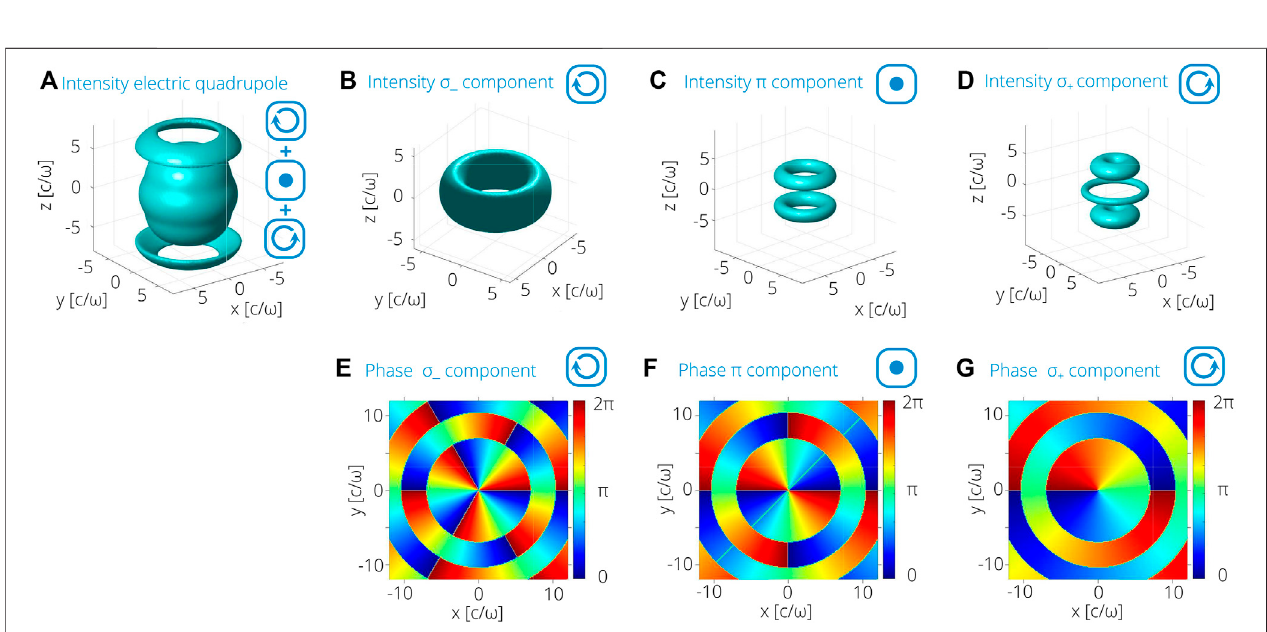
FIGURE 3 | Isosurfaces of an electric quadrupole Y ( E ) 22 spherical wave at 40% of the intensity divided into: (A) total intensity; (B) σ − polarization component; (C) π polarization component; and (D) σ + components of the polarization. In (E – G) the phase distributions at the z = 0 plane are plotted for different polarization